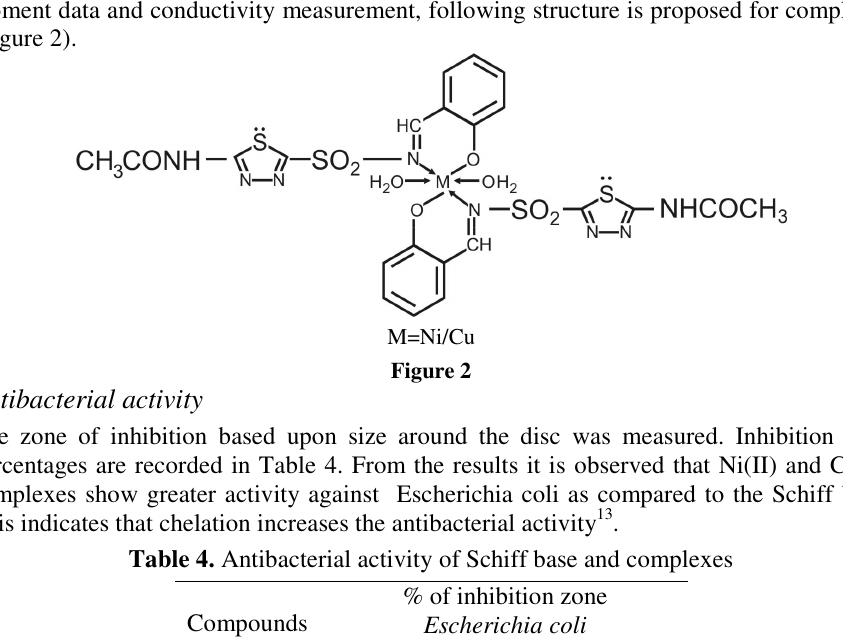
(vs = very strong, s = strong, m = medium, w = weak).